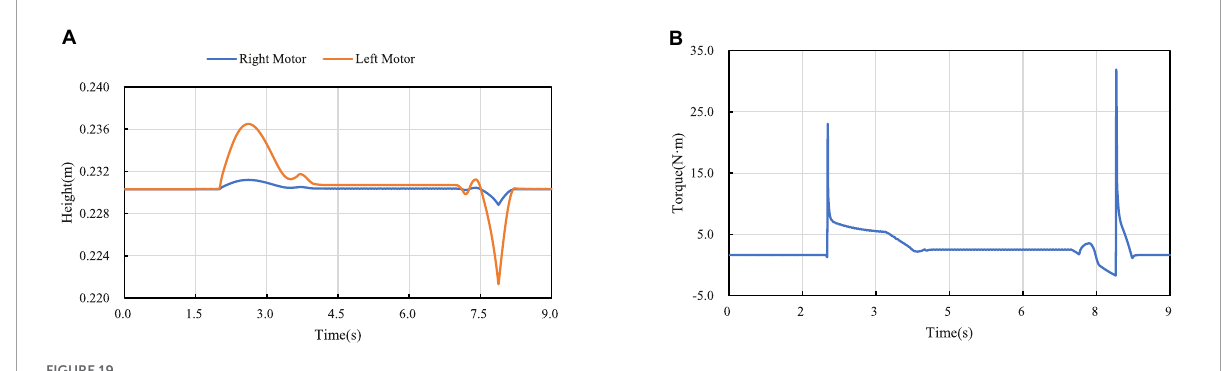
FIGURE19 Crossing the obstacle with one leg: (A) Diagram of motors’ locations; (B) Diagram of motors’ torques.